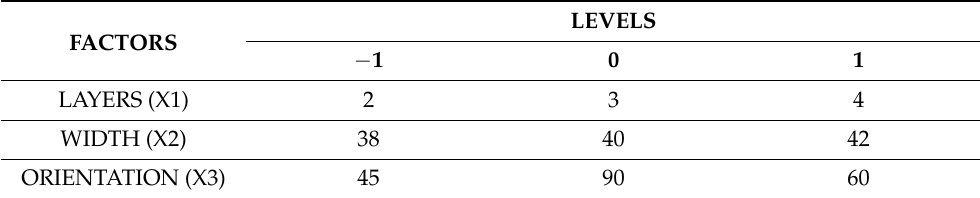
Table 1. Levels and factors.